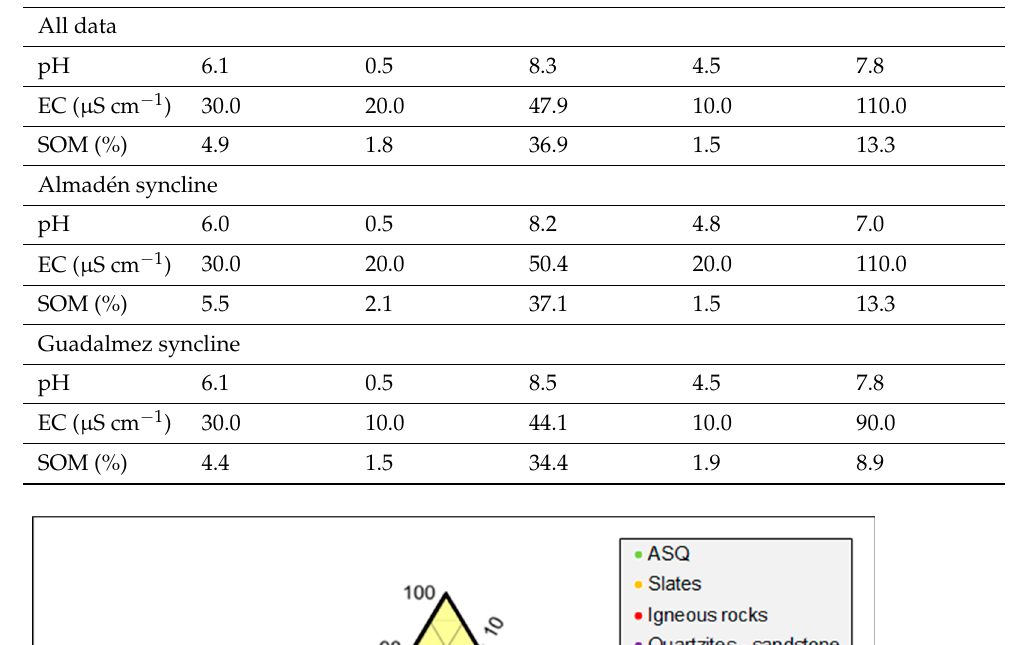
Table 1. Statistical summary of pedological parameters. Abbreviations: SD: standard deviation; SOM: soil organic matter; VC: variation coefficient. Complete data available in Table S1.